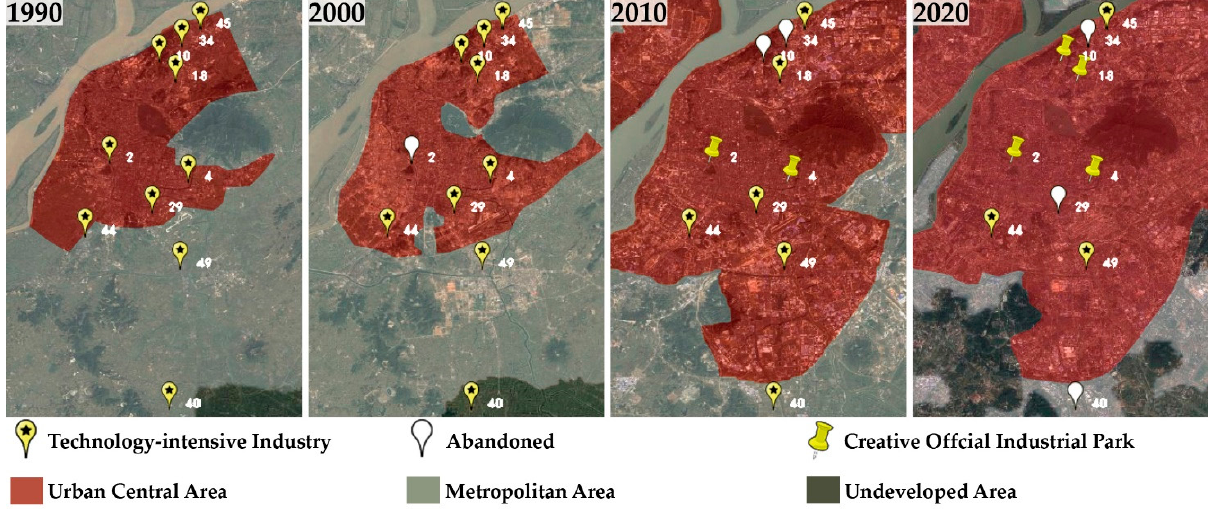
Figure 21. The change in the relationship between the operation state of technology-intensive industries and urban growth boundary over time (Figure source: own drawing; data source: on-site investigation and interview).